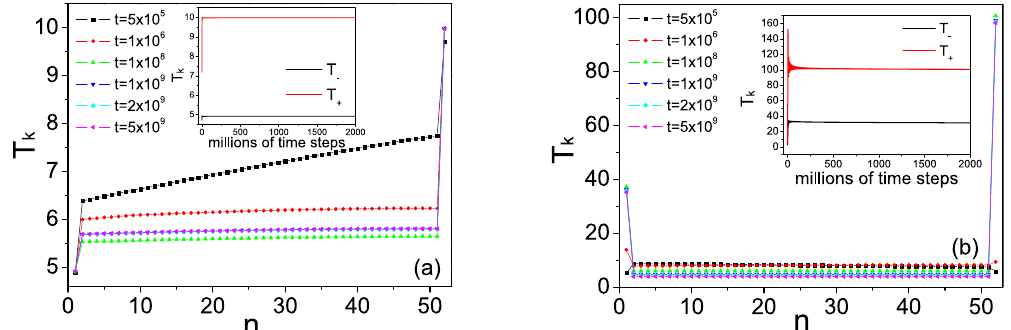
Figure 6. Temperature profiles for different average time. Energy of respective log-oscillators is initially given by ( a ) E − = 1 and E + = 20; ( b ) E − = 40 and E + = 80. From top to bottom, the average time is 5 × 10 5 , 10 6 , 10 8 , 10 9 , 2 × 10 9 and 5 × 10 9 time steps, respectively. Inset: Temperatures of the left and right log-oscillators (denoted by T − and T + ) as a function of the average time. The parameters for log-oscillators are set by τ − = 5, τ + = 10 and ε = 0.0001. The coupling parameters between thermostats and the system are set by γ − = 0.0005, γ + = 0.00005. The system size N =